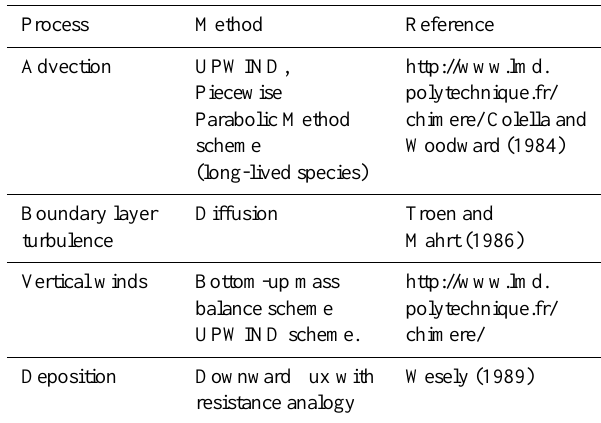
Fig. 4. Same as Fig. 3 but for SZA = 35°.